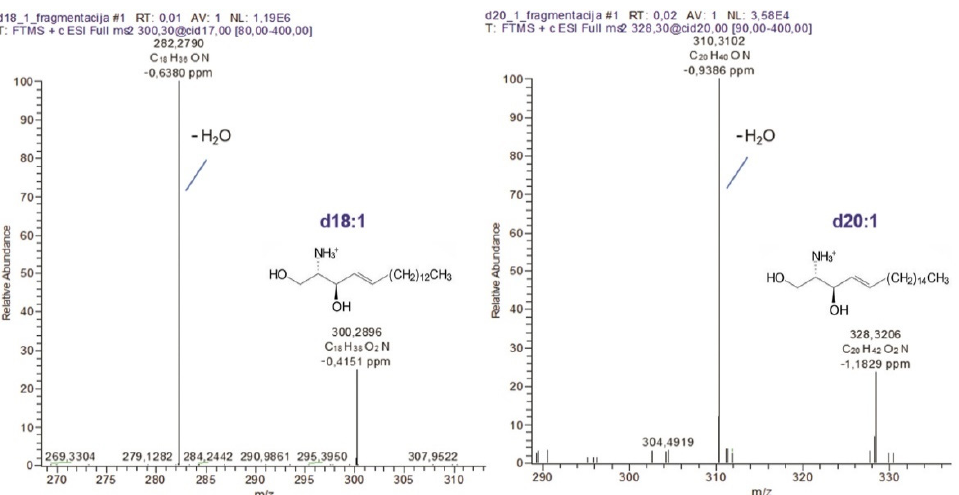
Figure 6. Fragmentation spectra obtained via HR MS 2 of positively charged molecular ions [M+H + ] + at m/z 300.2891 and 328.3201 confirming sphingosine (d18:1) and eicosasphingosine (d20:1) structures from anaplastic ganglioglioma tumor ganglioside extract. Table 2. Theoretical and experimental m/z values and the corresponding molecular formulas of positively charged precursor and dehydrated fragment ions of sphingosine (d18:1) and eicosasphingosine (d20:1) isolated from the AGGL acidic GSL mixture and characterized by HR-MS CID tandem MS. Mass accuracy is expressed in ppm.